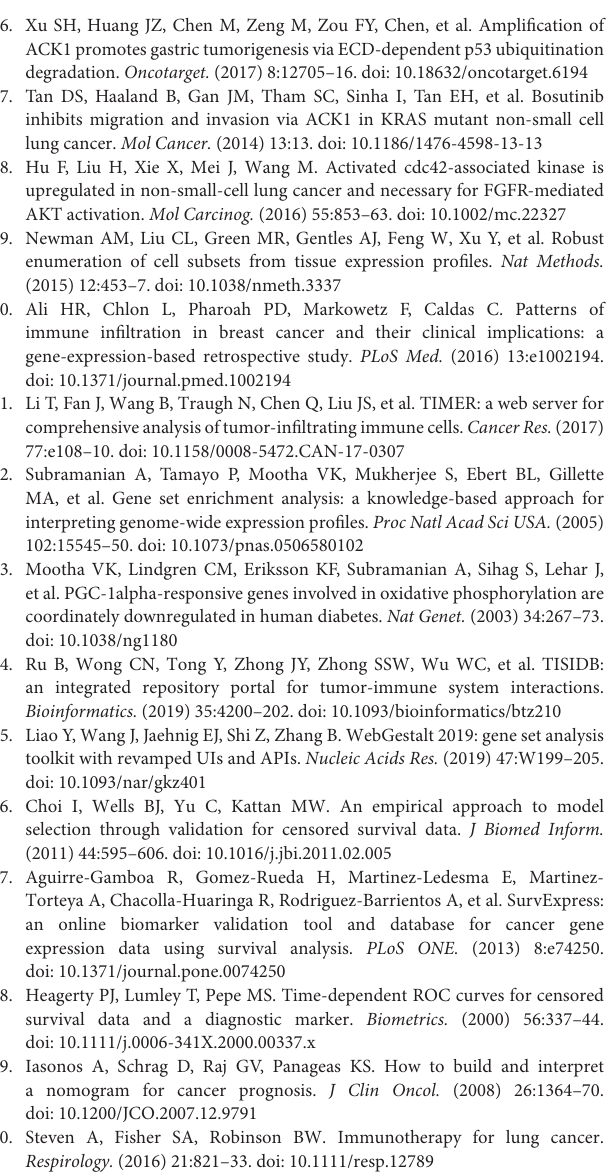
Supplementary Figure 1 | The abundance of 22 infiltrating immune cell subsets in cancerous and healthy biopsies for TCGA-LUAD (A) and -LUSC (B) cohorts calculated by the CIBERSORT method. Supplementary Figure 2 | Kaplan-Meier curves described the association between survival and six tumor immune cells as well as the ACK1 / TNK2 gene via the TIMER web-based tool (cistrome.dfci.harvard.edu/TIMER/) for LUAD (A) and LUSC (B) . Supplementary Figure 3 | Boxplots of ACK1 / TNK2 expression levels in tumor and normal tissues, as